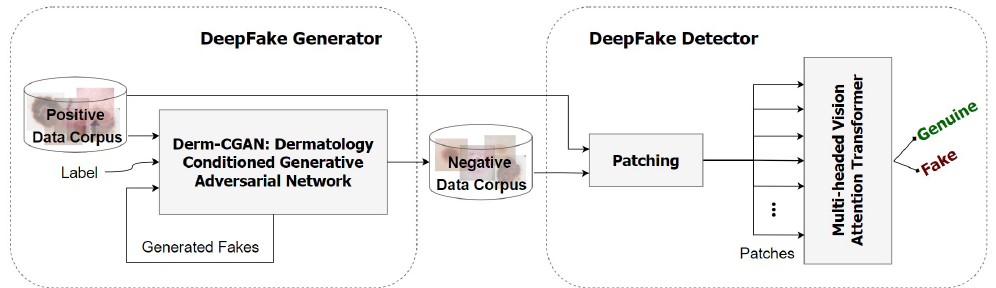
Figure 2. Overall structure of the proposed